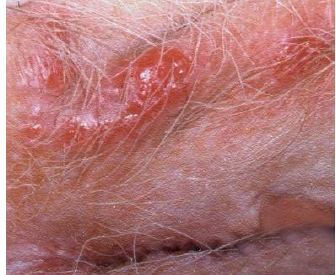
Figure 4. Folliculitis.